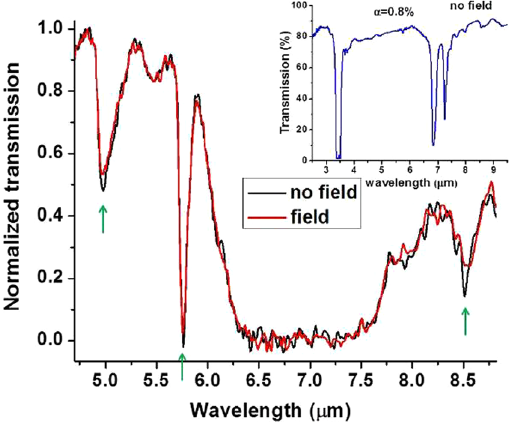
Figure 5. Comparison of the FTIR transmission spectra of the ferrofluid with and without external magnetic field shows clear influence of the Purcell effect on the narrow absorption lines of the ferrofluid. Application of the external magnetic field, which leads to formation of the hyperbolic metamaterial structure, makes the radiation lifetime shorter, leading to broader and less pronounced absorption lines (marked by green arrows). The inset shows FTIR transmission spectrum of the diluted ( α ∞ = 0.8%) ferrofluid in zero magnetic field. It reveals strong kerosene absorption lines, which separate low absorption regions of the LWIR spectrum where the Purcell effect measurements have been performed.